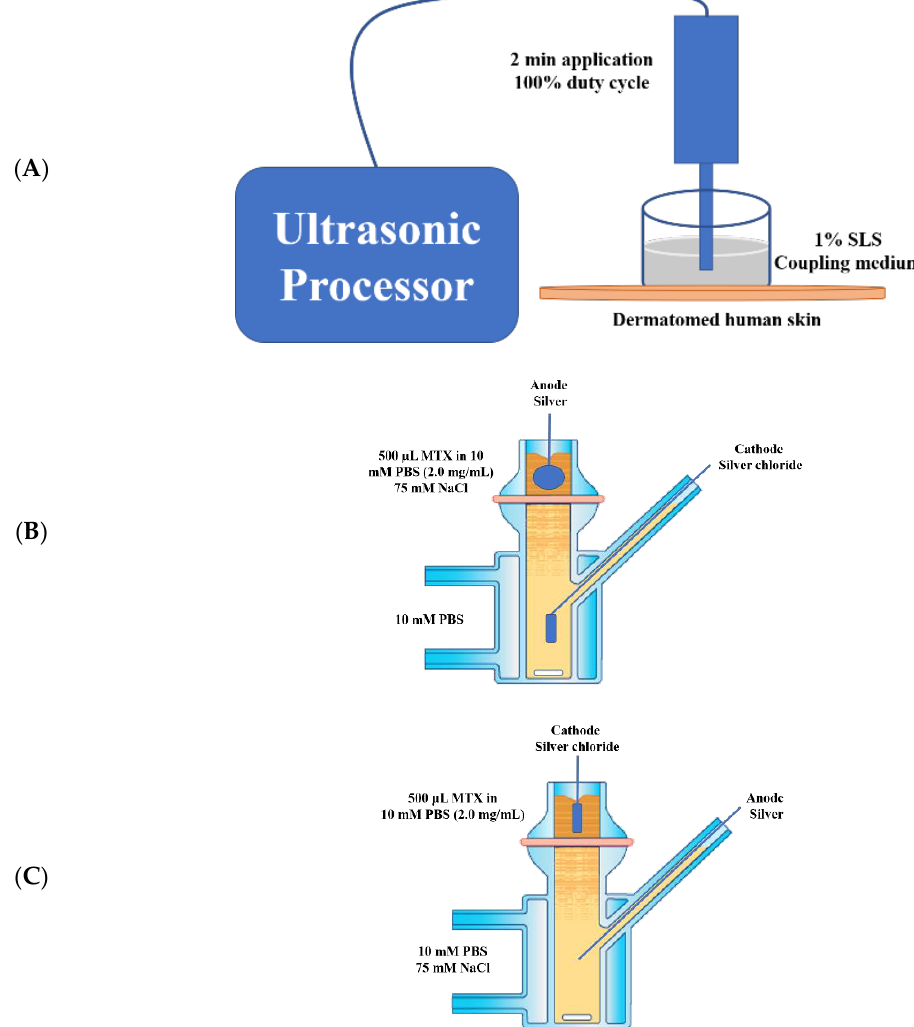
Figure 1. Experimental setup of ( A ) low-frequency sonophoresis (LFS), ( B ) anodal iontophoresis (anodal ITP), and ( C ) cathodal iontophoresis (cathodal ITP).